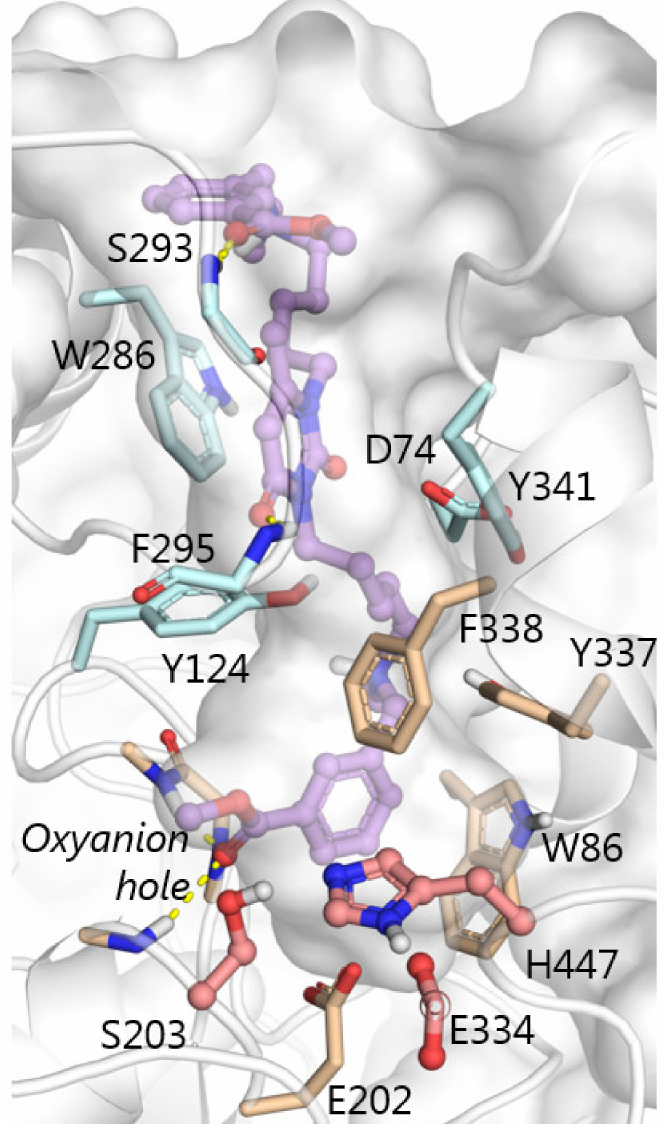
Figure 4. Pose of compound 2c inside the active site and gorge of human AChE, obtained by molecular docking. Carbon atoms of the catalytic triad are colored pink, of the active site—beige, peripheral anionic site—cyan. Side chain of Phe295 is not shown. Protein surface shows AChE gorge engulfing the